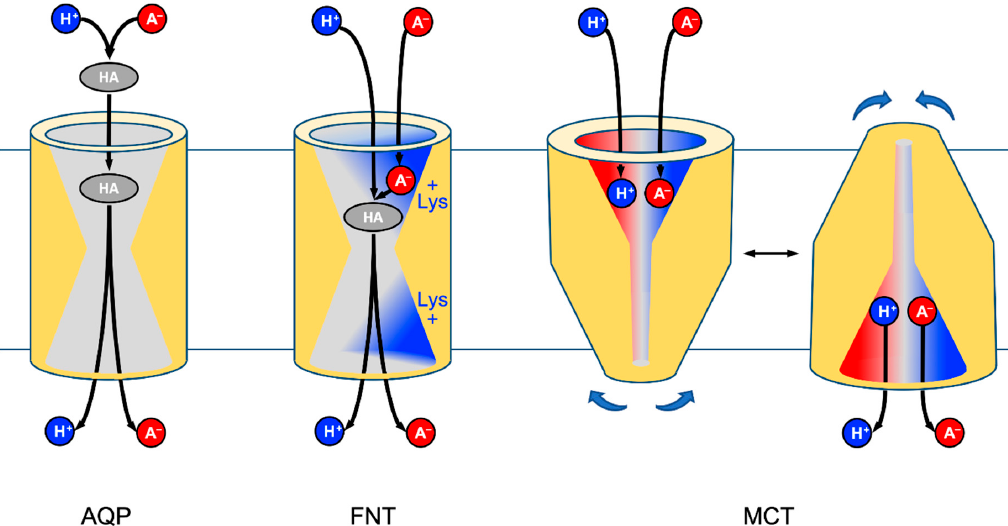
Figure 7. Substrate acquisition and transmembrane transfer at the protomer level of AQPs (neutral solutes), FNTs (substrate anion attraction and protonation due to dielectric environment), and MCTs (alternating access secondary active co-transport of substrate and